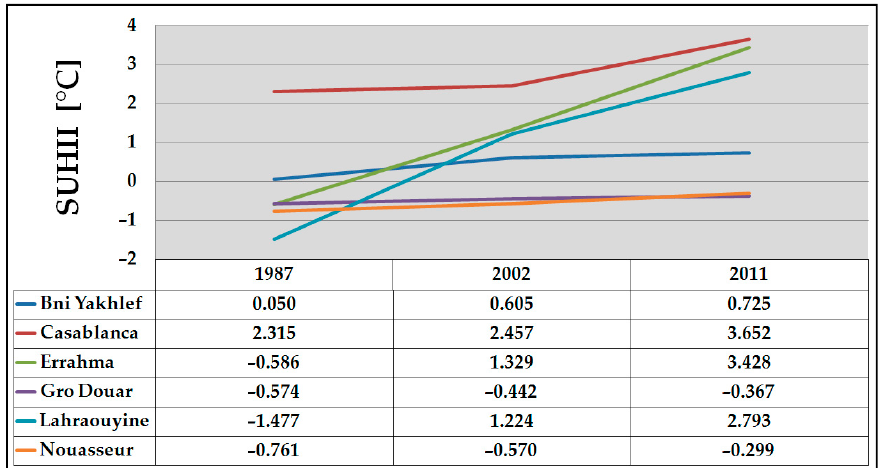
Figure 8. Variation of the average daytime SUHII during winter from 1987 to 2011 (obtained from average winter SUHII in 1987, 2002 and 2011).